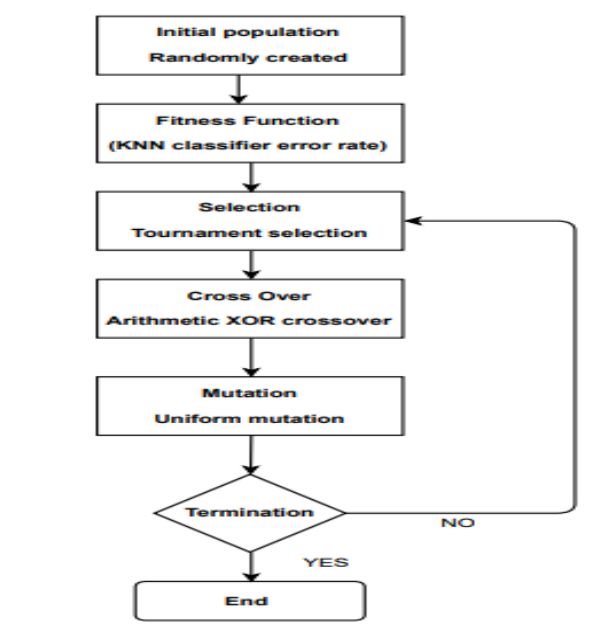
Fig. 2. The proposed genetic algorithm for feature selection.